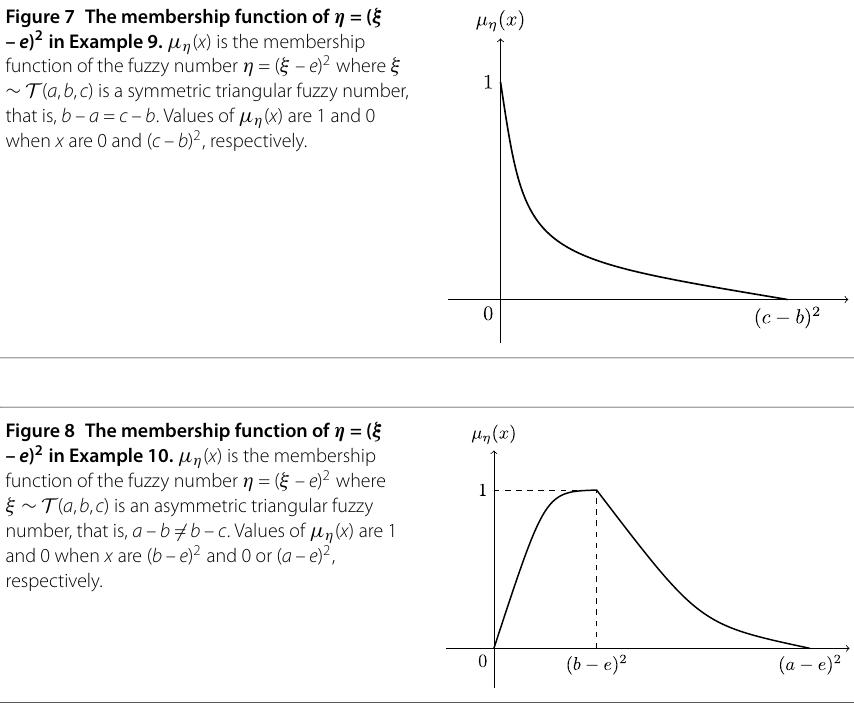
Figure 7 The membership function of η = ( ξ – e ) 2 in Example 9. μ η ( x ) is the membership function of the fuzzy number η = ( ξ – e ) 2 where ξ ∼ T ( a , b , c ) is a symmetric triangular fuzzy number, that is, b – a = c – b . Values of μ η ( x ) are 1 and 0 when x are 0 and ( c – b ) 2 , respectively.